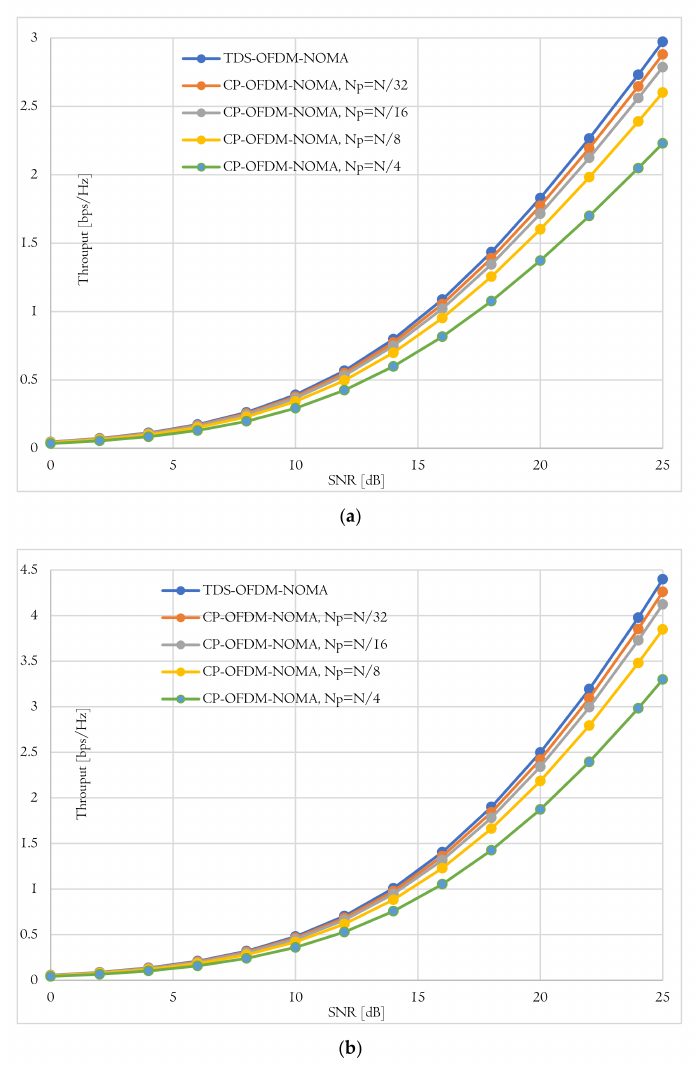
Figure 7. Average throughput achieved by TDS-OFDM-NOMA and CP-OFDM-NOMA under different pilots’ length for ( a ) Near user and ( b ) Far